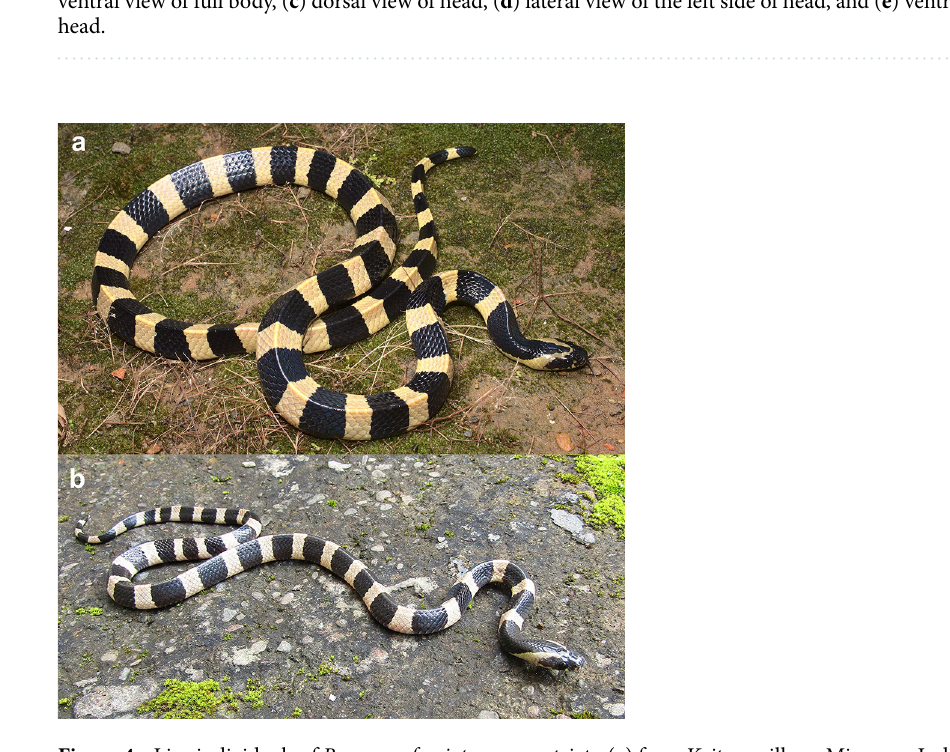
Figure 4. Live individuals of Bungarus fasciatus sensu stricto ( a ) from Keitum village, Mizoram, India (MZMU1421), and ( b ) a juvenile with creamish dorsum coloration from Saikhawthlir village, Mizoram,